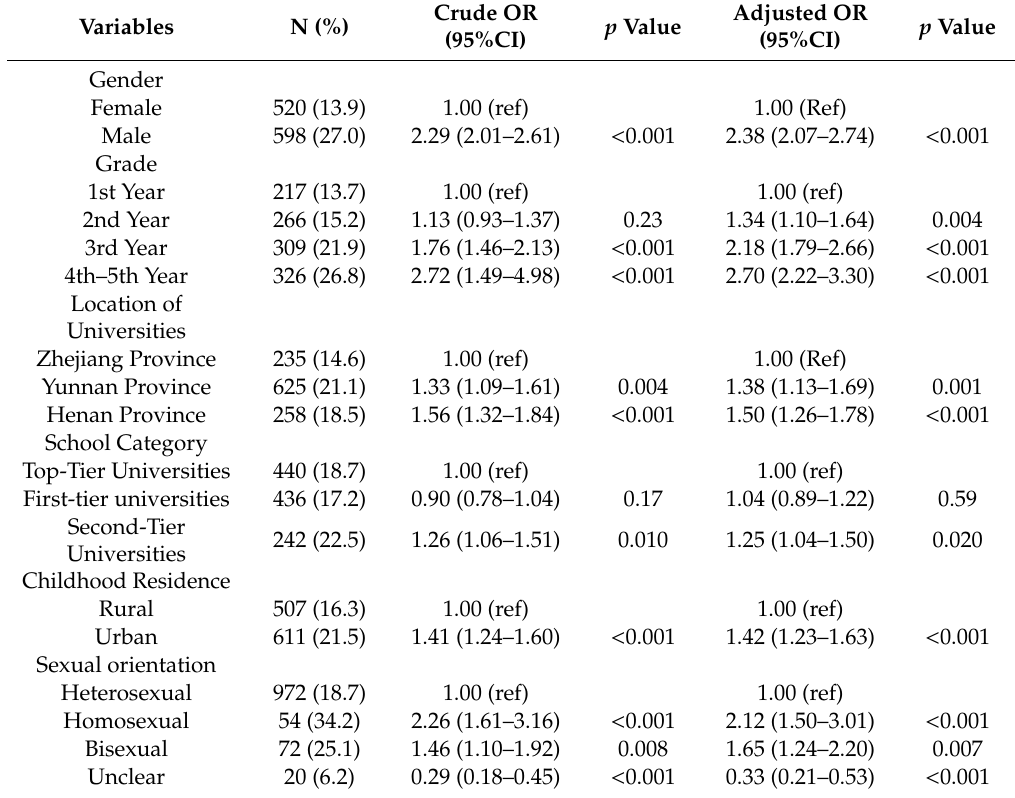
Table 7. Factors associated with ever having sexual intercourse among Chinese university